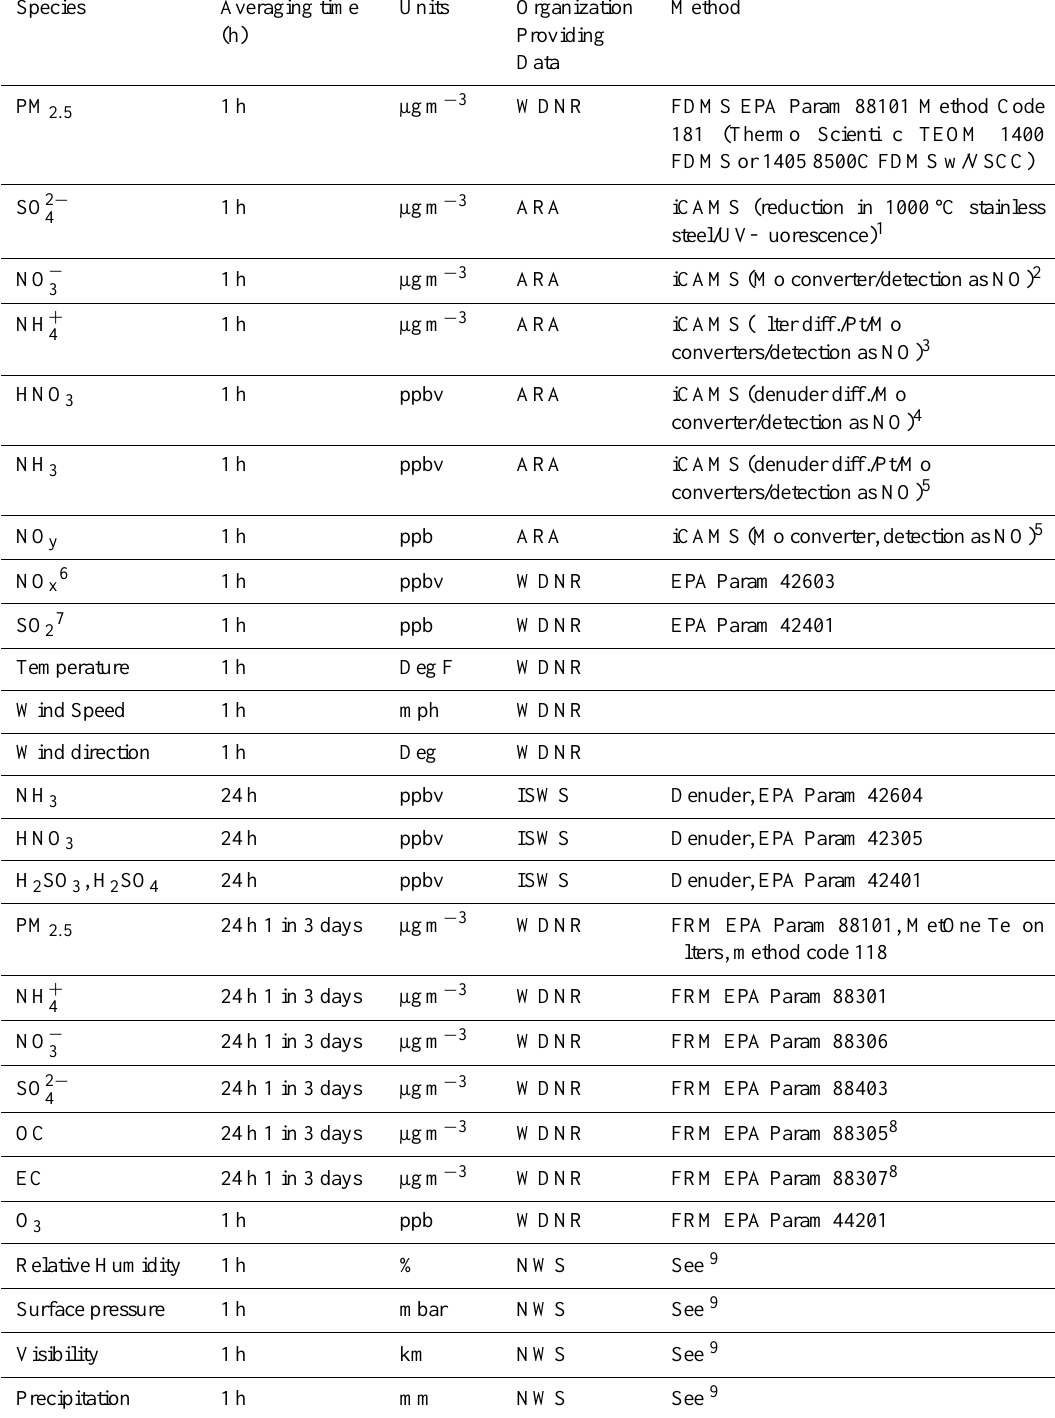
Table 3. List of monitored